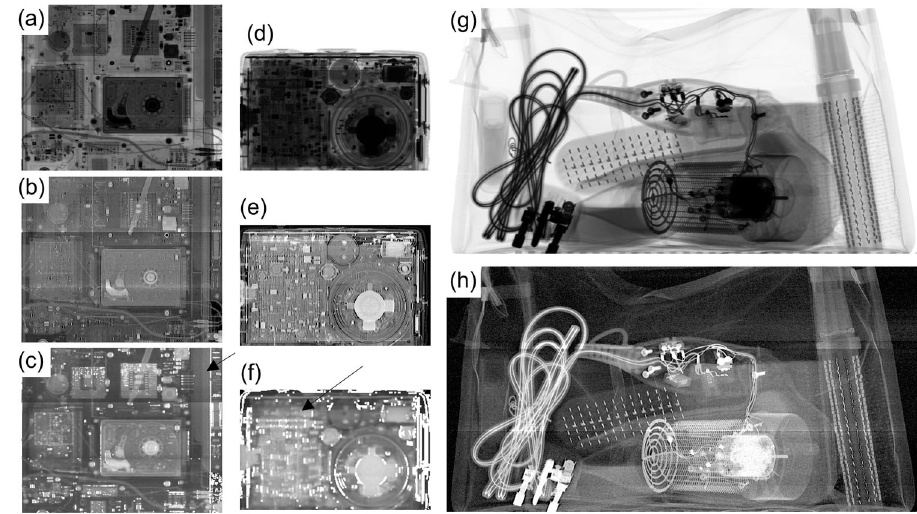
Fig. 4 | Example images from PoC test 2. Attenuation ( a , d ), dark- fi eld ( b , e ) and ratio ( c , f ) images of the laptop and mobile phone (respectively) in which a small quantity of C4 was concealed are shown. Arrows in panels c and f point at the